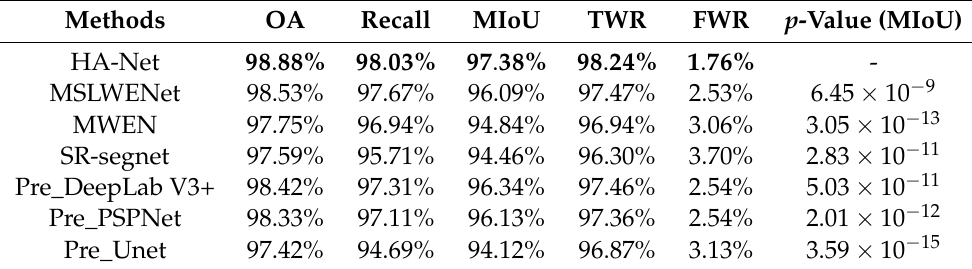
Table 1. The quantitative results of comparing the proposed method against other methods.